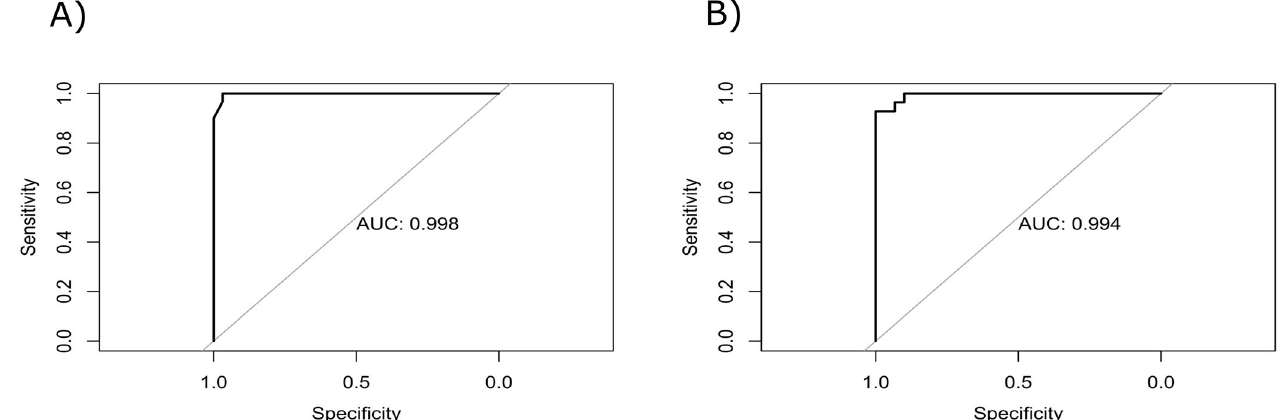
Fig 2. Area under the curve (AUC) of Receiver Operating Characteristic (ROC) curve for: A) Regression model for diagnosis of patients with first episode of major depression from healthy controls. B) Regression model for major depression disorder chronicity, for discrimination between patients in first depressive episode and patients with treatment-resistant